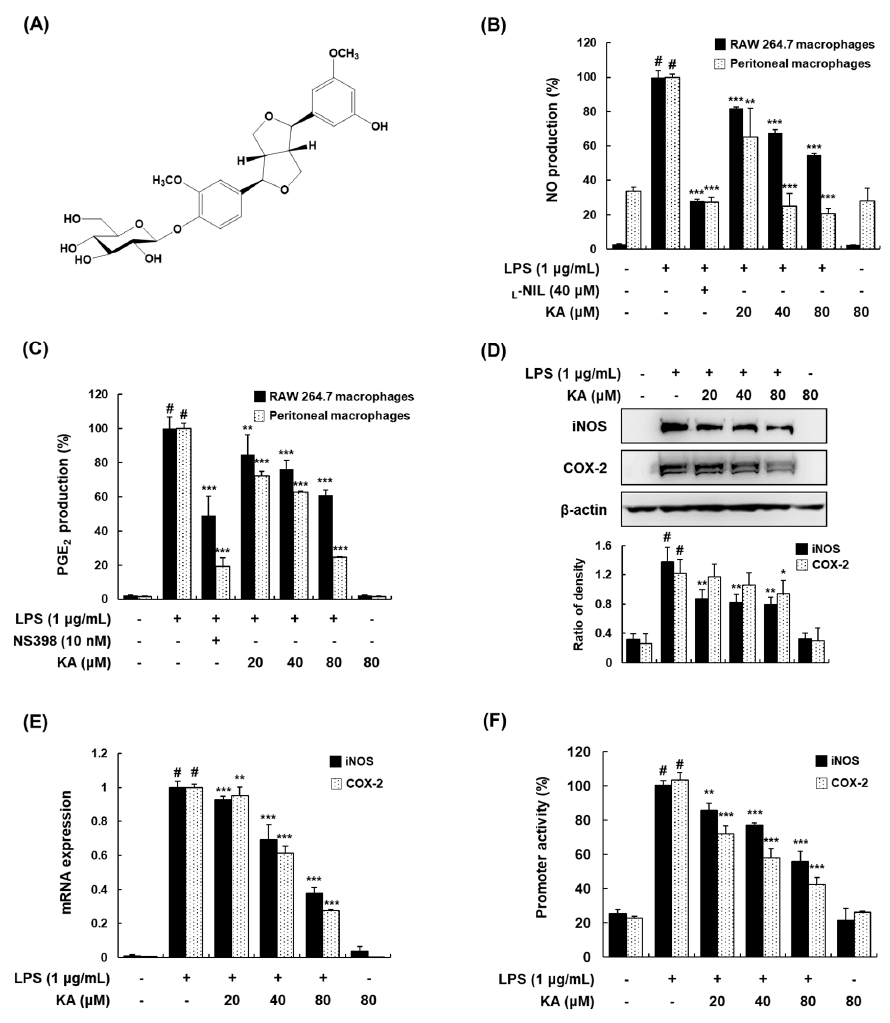
Figure 1. Effects of koreanaside A (KA) on nitric oxide (NO) and prostaglandin E 2 (PGE 2 ) production and the expression of inducible nitric oxide synthase (iNOS) and cyclooxygenase-2 (COX-2) and their promoter activity in lipopolysaccharide (LPS)-induced RAW 264.7 macrophages. ( A ) Structure of KA. ( B , C ) Cells were pretreated with KA (20, 40, or 80 μ M) for 1 h and then stimulated with LPS (1 μ g/mL) for 24 h. NO and PGE 2 production in the culture media were quantified using the Griess assay and an enzyme immunoassay ( EIA) kit, respectively. Positive controls for NO and PGE 2 production were L - NIL (40 μ M) and NS-398 (10 nM), respectively. ( D ) Lysates were prepared from cells pretreated with KA (20, 40, or 80 μ M) for 1 h and then stimulated with LPS for 24 h. Total cellular proteins were prepared and resolved by SDS-PAGE, and detected using specific iNOS and COX-2 antibodies. β - actin was used as an internal control. ( E ) Total RNA was prepared from cells stimulated with LPS for 4 h in the presence of KA (20, 40, or 80 μ M) for qRT-PCR analysis of iNOS and COX-2. The levels of iNOS and COX-2 were adjusted by β -actin expression. ( F ) Cells were transiently transfected with a pGL3-iNOS or a pGL3-COX-2 promoter vector, and a phRL-TK vector was used as an internal control. Cells were pretreated with KA (20, 40, or 80 μ M) for 1 h and then stimulated with LPS for 18 h. The values shown are the mean ± SDs of three independent experiments. # P < 0.05 vs. the control group; ⁎ P < 0.05, ⁎⁎ P < 0.01, ⁎⁎⁎ P < 0.001 vs. LPS-stimulated